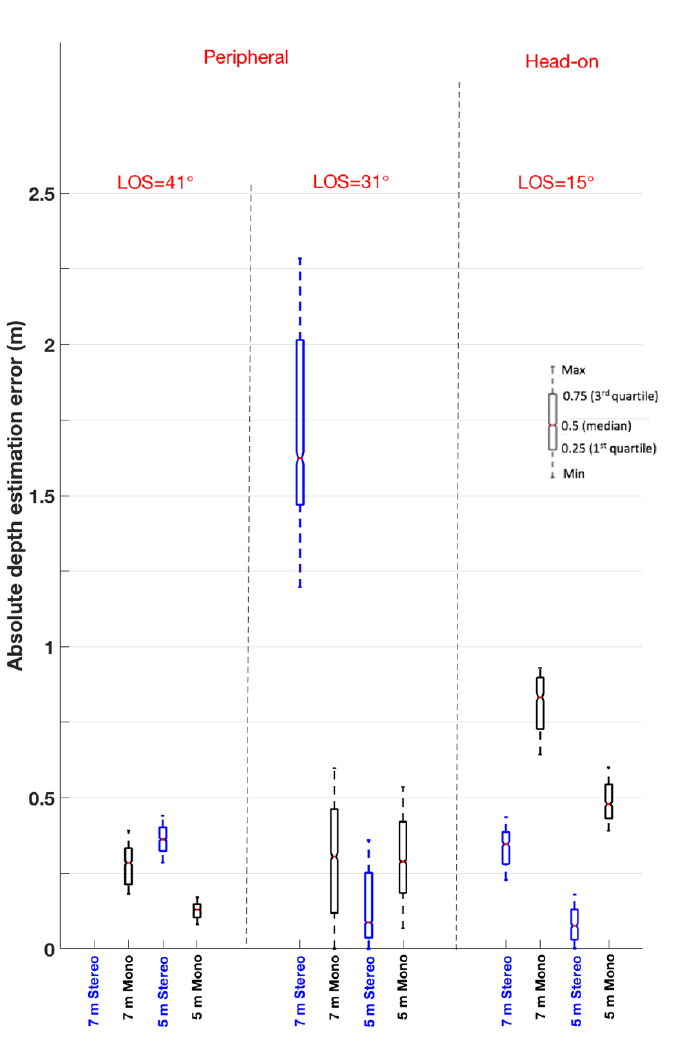
Figure 6. Absolute depth estimation error for both approaches at different distances. The errors are represented by the minimum, first quartile, median, third quartile, and maximum of a set of data and shown by box-and-whisker plots. For peripheral point features when line-of-sight (LOS) is 41 ◦ the effective range of stereo camera is less than 7 m, therefore the corresponding box is not shown.